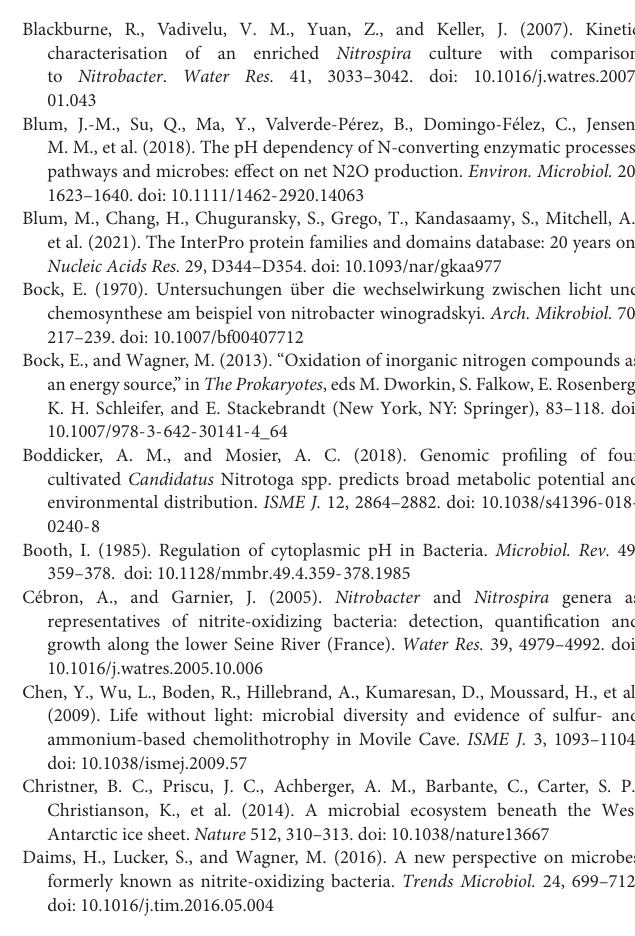
− + NO − -N) in the 3 -N) and (B) nitrate and nitrite as nitrogen ( µ M NO 3 2 experimental dataset obtained by the Northern Water Conservation District at the nearby site approximately 2 miles away on the same river. Supplementary Figure 2 | Water column data measured at the CP45 site (gray symbols) or obtained by the Northern Water Conservation District at the nearby site approximately 2 miles away (black symbols) for (A) pH, (B) turbidity, and (C) temperature. (D) Water temperature at 15-min intervals around the clock for the 12-month time period from a Northern Water Conservation District sampling site approximately 9 miles away from the experimental sampling site. Supplementary Table 1 | Mean nitrite oxidation rates ( µ M day − 1 ) at varying treatment conditions, with accompanying standard deviation values of replicate cultures. Data should be compared within an experiment, but not necessarily between experiments (see section “Materials and